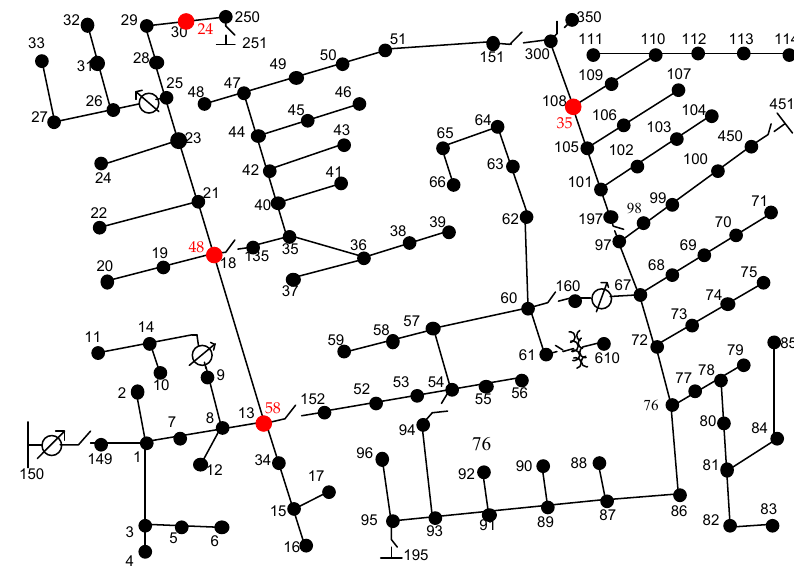
Figure 18. The locations of EV charging stations in the power grid.